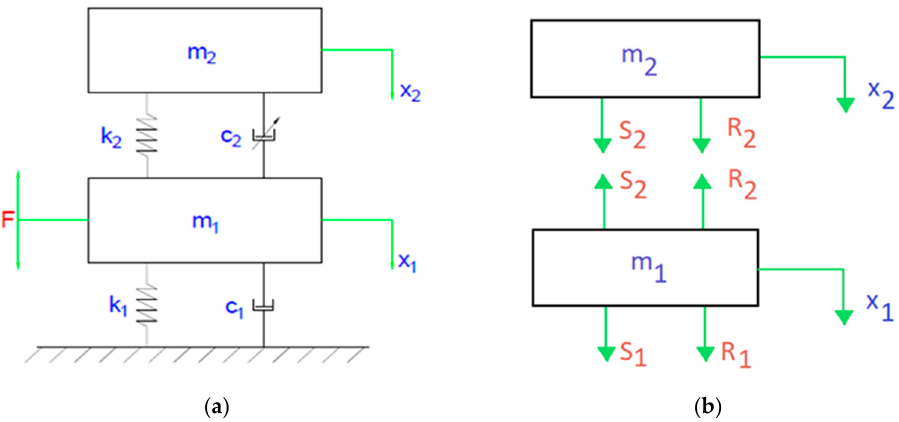
Figure 1. Model of a quarter car, ( a ) diagram of the analyzed system, ( b ) breaking from the constraints of the force arrangement diagram; m 1 —tyre mass (unsprung mass), k 1 —tyre spring stiffness, c 1 —tyre damping coefficient, x 1 —wheel displacement, m 2 —body mass, k 2 —suspension spring stiffness, c 2 —controlled damping coefficient, x 2 —body displacement, F—force acting in suspension, S 1 —spring force in tyre, R 1 —damping force in tyre, S 2 —spring force in suspension, R 2 —controlled damping force in suspension.